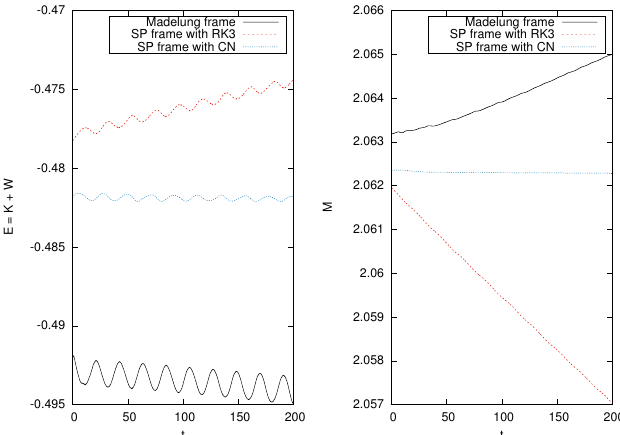
Figure 3. Evolution of the total energy E = K + W and the mass M of the equilibrium configuration in the two